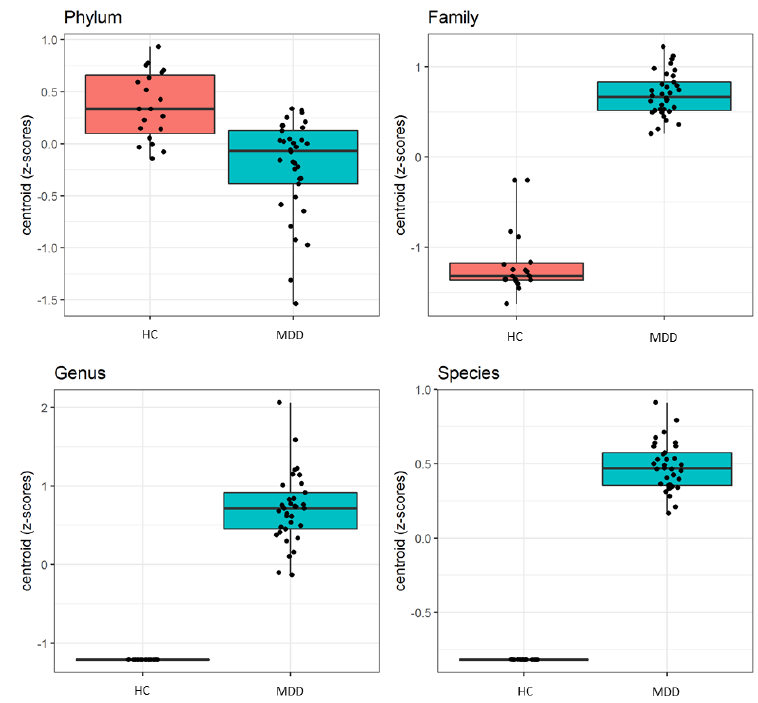
Figure 3. Boxplots of centroid Z-scores, computed by the penalized logistic regression analysis algorithm, which discriminated all patients with major depressive disorder (MDD) from healthy controls (HC).